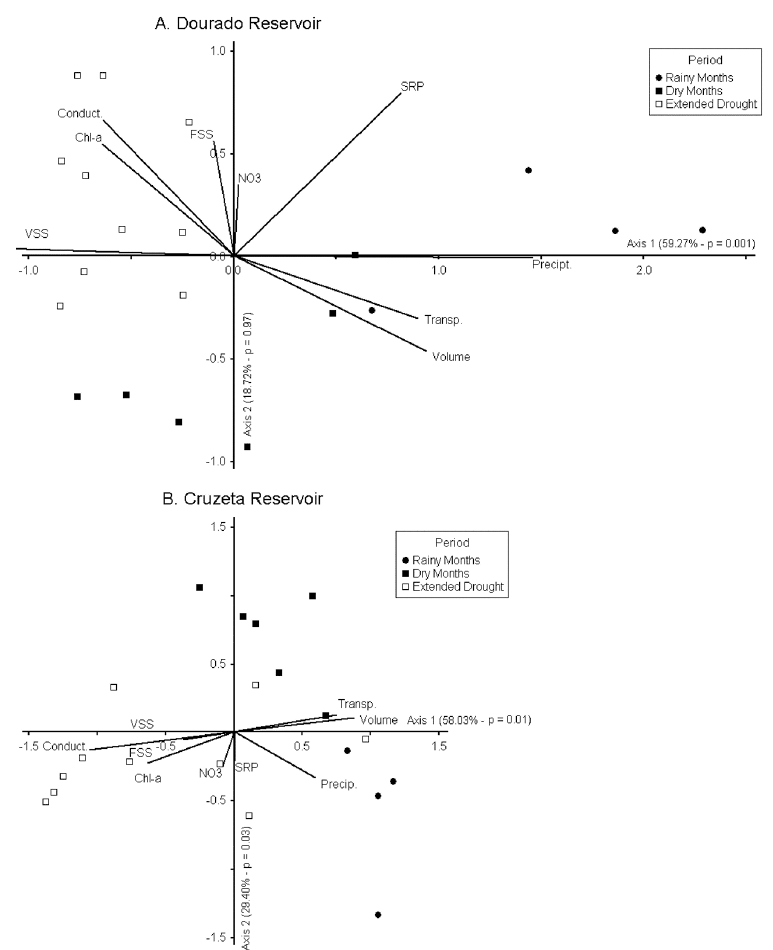
Figure 6. Principal components analysis (PCA) scores applied to environmental variables in Dourado ( A ) and Cruzeta ( B ) reservoirs. Monthly sample units were classified according to period classification (Figure 5). A. Dourado : Dark Dots and Dark squares = Rainy and Dry months (May 2011 to April 2012 and June 2012); White squares = Extended drought period (May 2012 and July 2012 to December 2012). B Cruzeta: Dark dots and Dark squares = Rainy and Dry months (May 2011 to April 2012); White squares = Extended drought period (May 2012 to December 2012). Precip. = Precipitation; Transp. = Transparency; Conduct. = Conductivity; FSS = Fixed Suspended Solids; VSS = Volatile Suspended Solids; Chl-a = Chlorophyll- a ; SRP = Soluble Reactive Phosphorus; NO